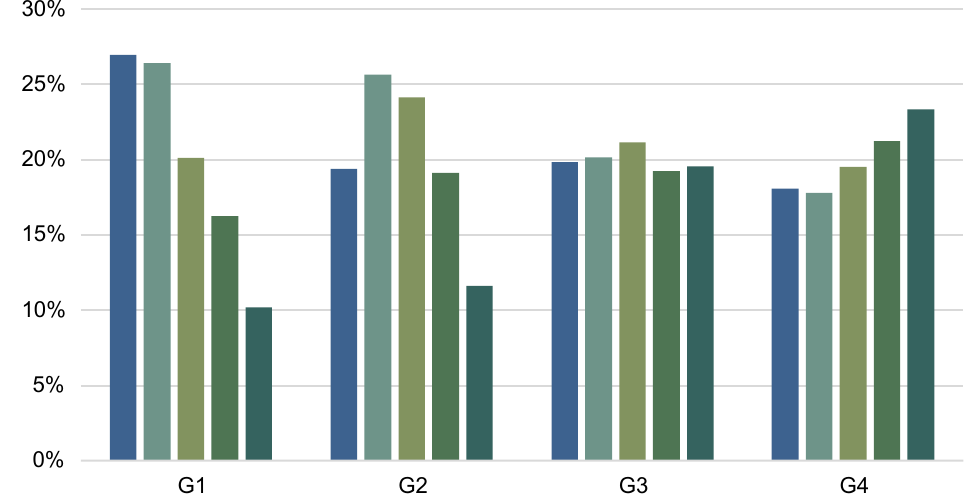
Figure 2. The income distribution of the four groups with different proportions of WAP. Note: Low, middle, low–middle, middle, middle–high, and high incomes represent the 0–20th, 20–40th, 40–60th, 60–80th, and 80–100th percentiles of the per capita income of the whole sample, respectively. G1 indicates a WAP proportion of 0–60%; G2 indicates a WAP proportion of WAP of 60–65%; G3 indicates a WAP proportion of 65–70%; G4 indicates a WAP proportion of